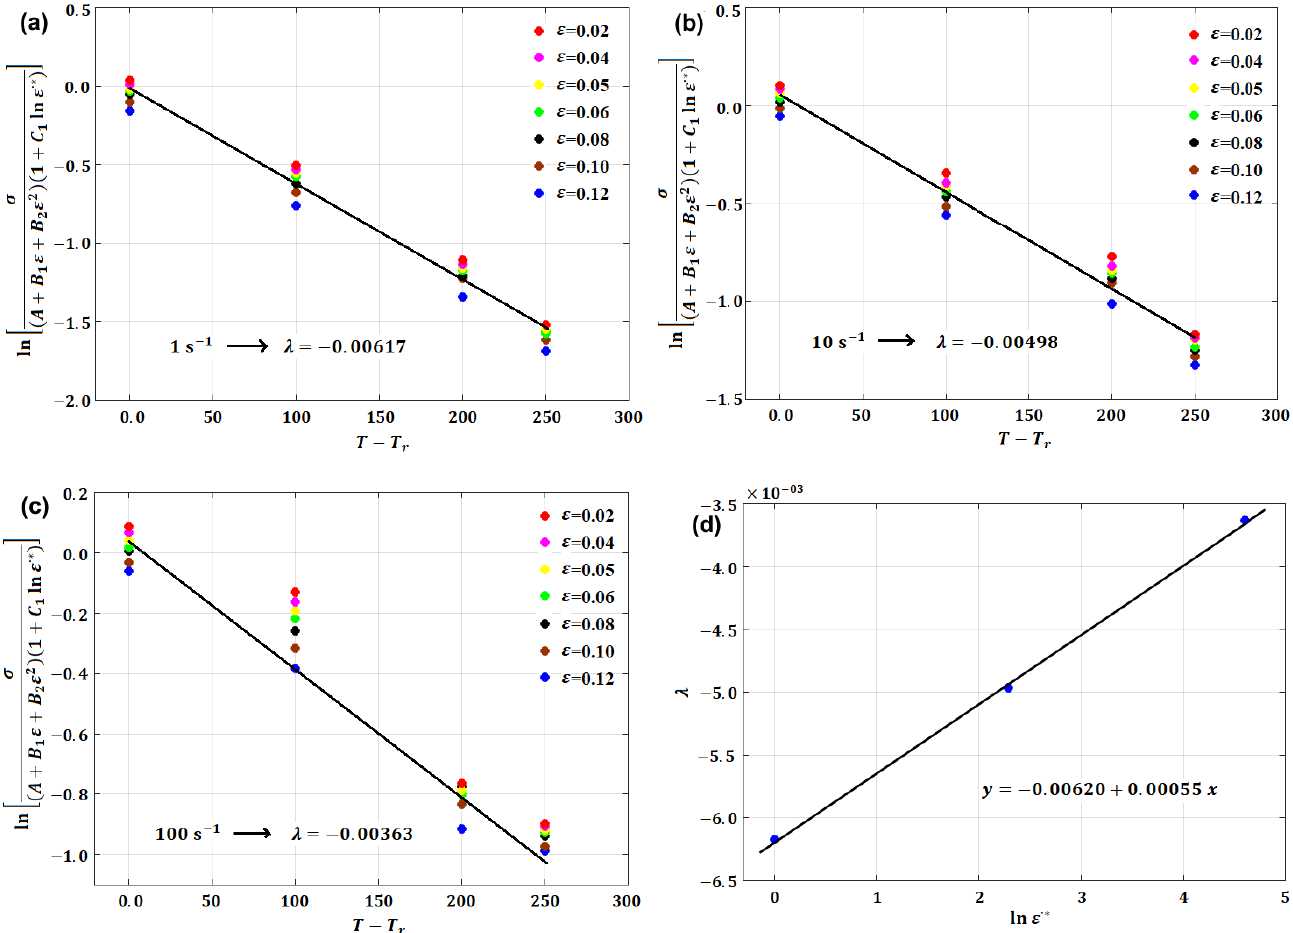
Figure 14. Determination of the modified JC constants 𝜆, 𝜆 1 , and 𝜆 2 : ( a ) 𝜆 at 1 s − 1 ; ( b ) 𝜆 at 10 s − 1 ; ( c ) 𝜆 at 100 s −1 ; ( d ) 𝜆 1 and 𝜆 2 .